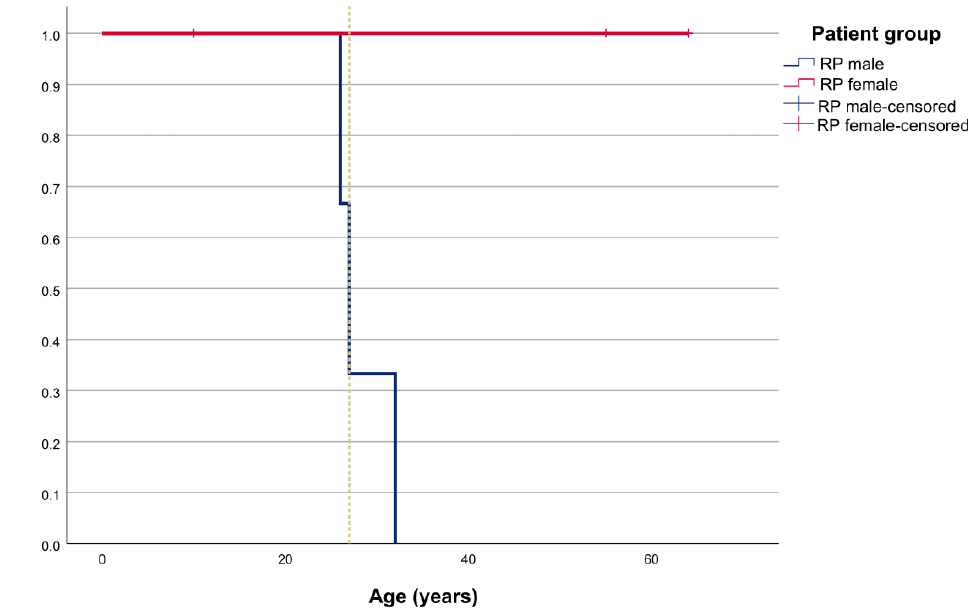
Figure 8. Kaplan–Meier survival analysis showing the ratio of male and female RP patients who reached legal blindness based on visual field (VF) (diameter < 20 ◦ ) with age. Dashed line represents when 50% of patients reached legal blindness.